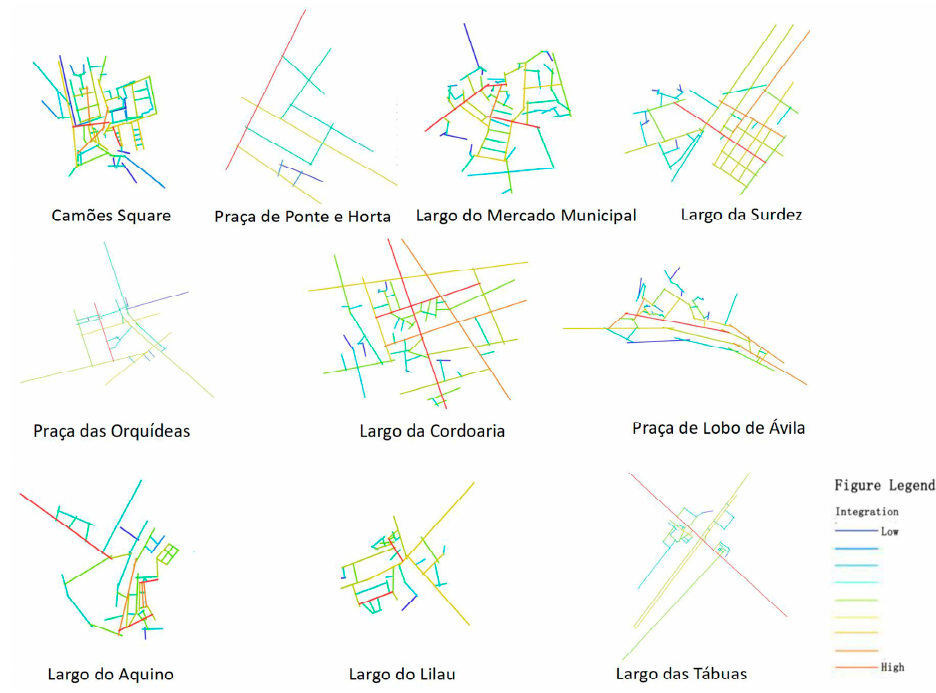
Figure 10. Community-related Largos.